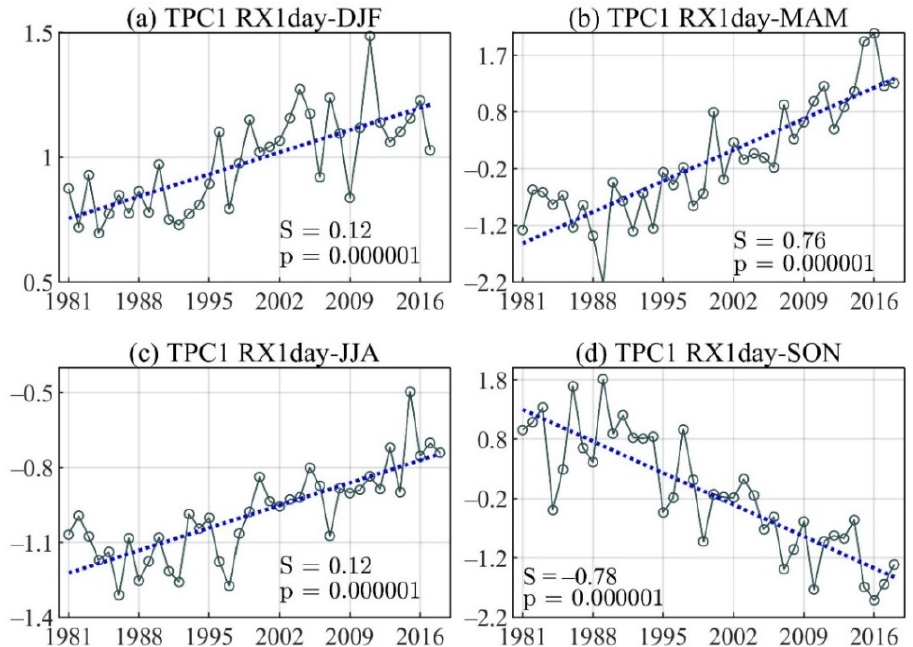
Figure A1. ( a) –( d ) Spatial pattern of Max 1-day precipitation amount (RX1day), ( e) –( h ) Number of wet days (R1mm), ( i) –( l ) Number of days with precipitations above R10mm (R10mm), ( m) –( p ) Con- secutive dry days (CDD), and ( q) –( t ) Consecutive wet days (CWD) for the first TEOF mode during December–February (DJF) ( first row ), March–May (MAM) ( second row ), June–August (JJA) ( third row ), and September–November (SON) ( last row ).